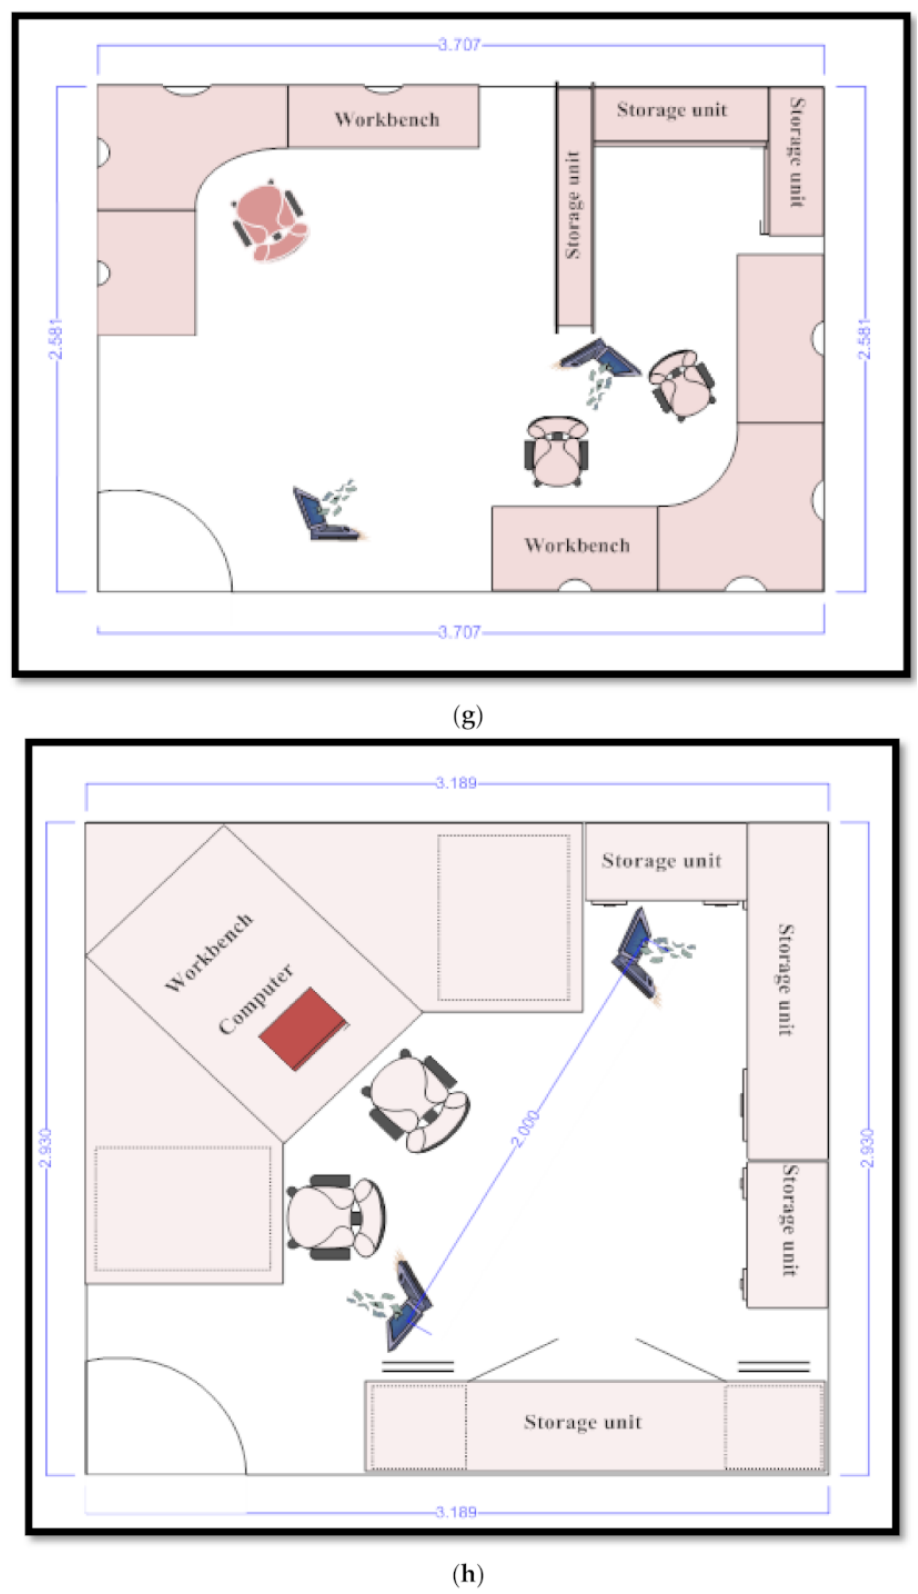
Figure 2. Auckland University of Technology (AUT) WT Building floor plans for laboratory, lunchroom, and office